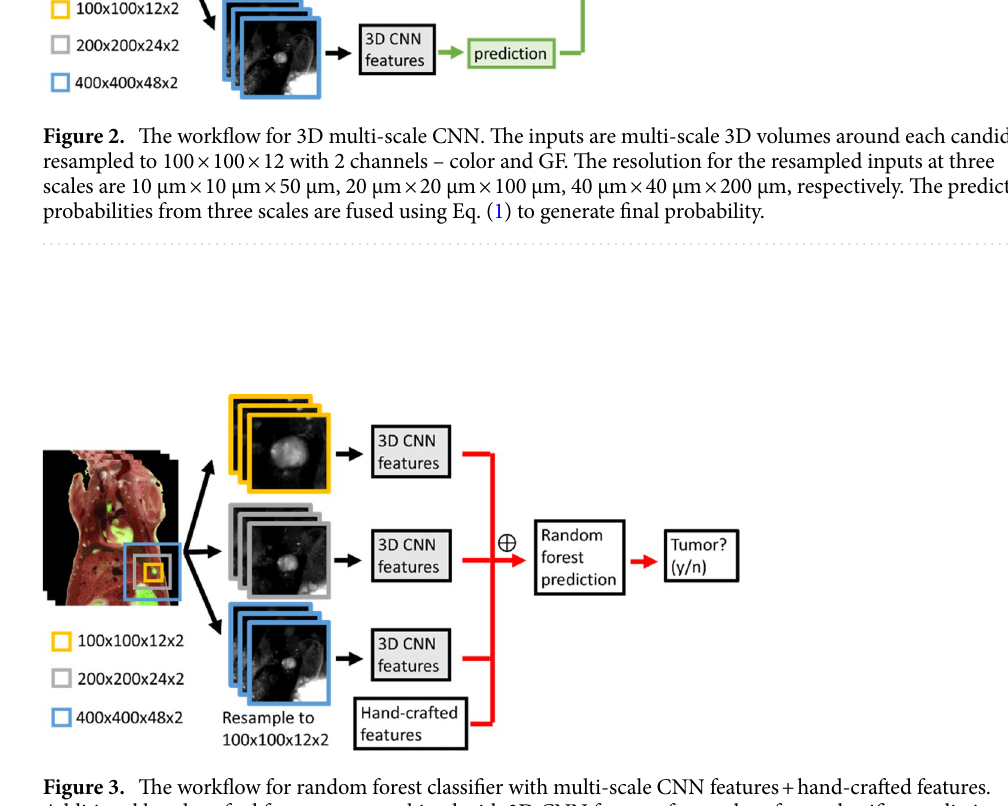
Figure 3. The workflow for random forest classifier with multi-scale CNN features + hand-crafted features. Additional hand-crafted features are combined with 3D CNN features for random forest classifier